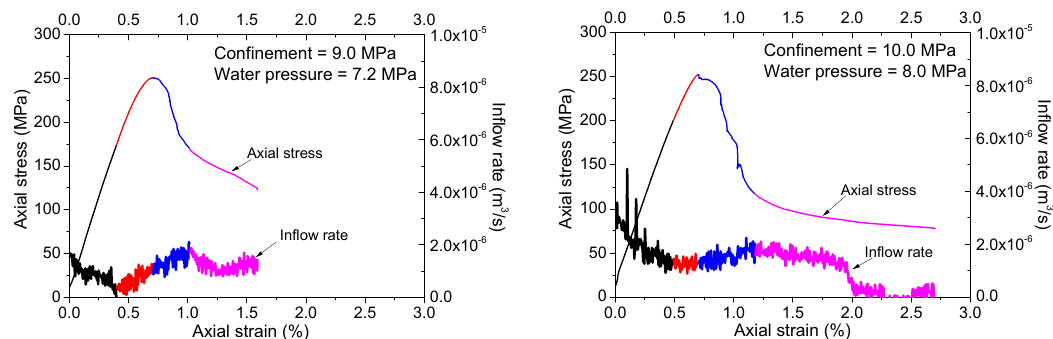
Figure 8. Axial stress–strain and inflow rate curves for the tests under different confinements and water pressures. The black, red, blue and magenta colors refer to stage I, II, III and IV, respectively.